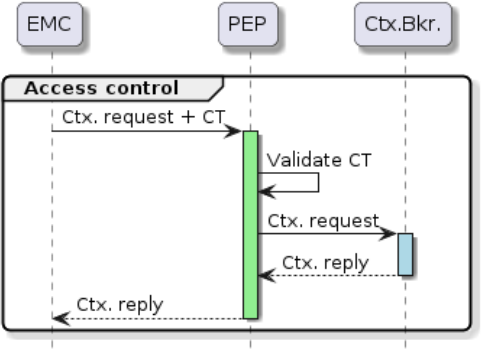
Figure 10. Authorisation enforcement sequence.